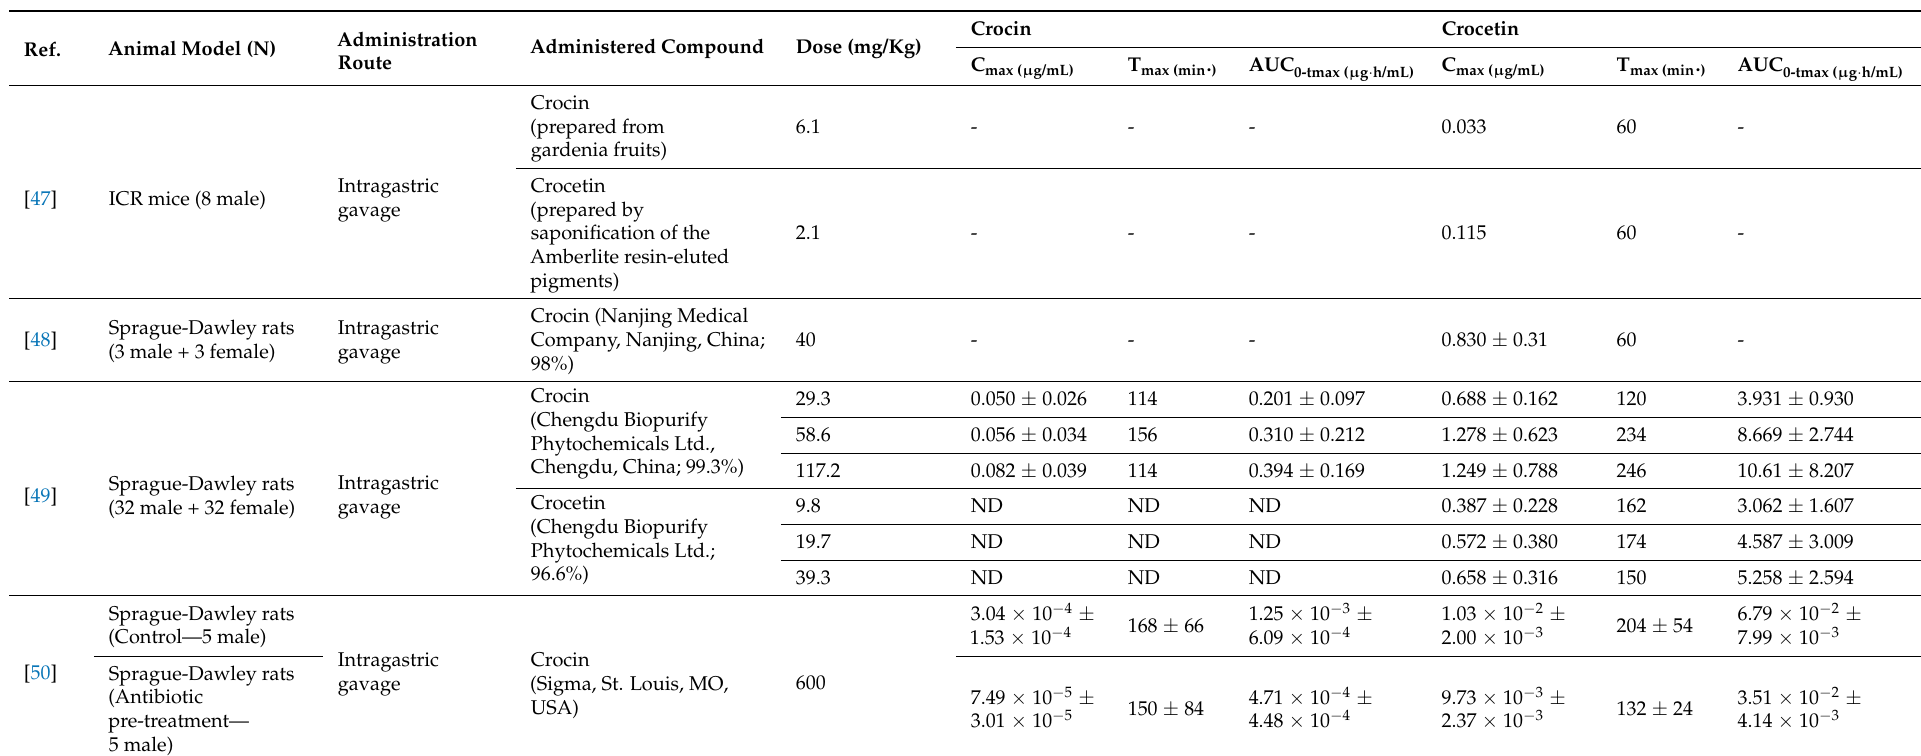
Table 2. Pharmacokinetic parameters estimated for crocin and crocetin in the plasma of animal models (rat, mice).